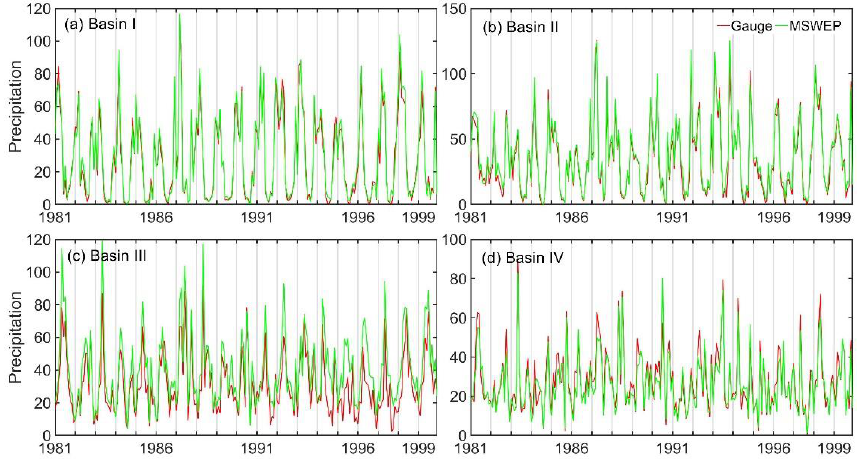
Figure 3. The precipitation temporal evolution of ground sites and MSWEP in each basin.